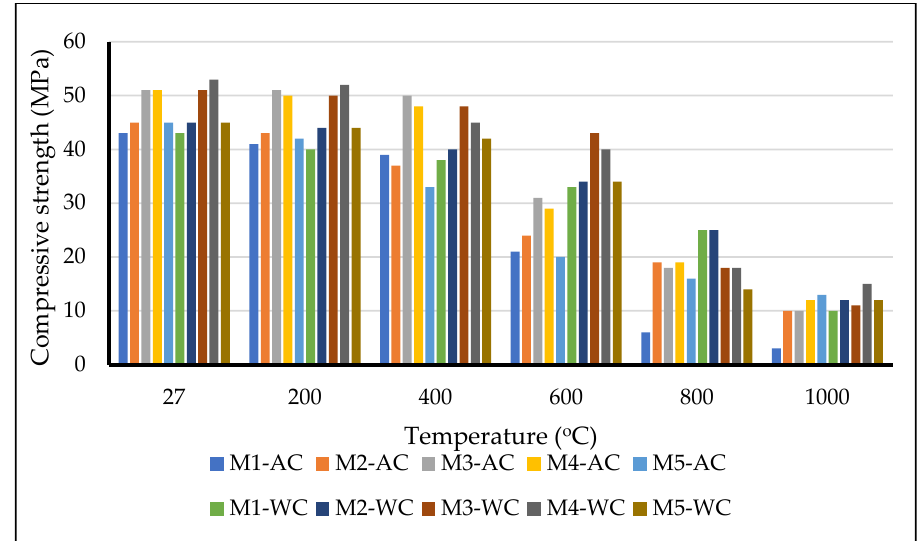
Figure 10. Compressive strength of air-cured samples at elevated temperatures (where AC is air cooling, and WC is water cooling).